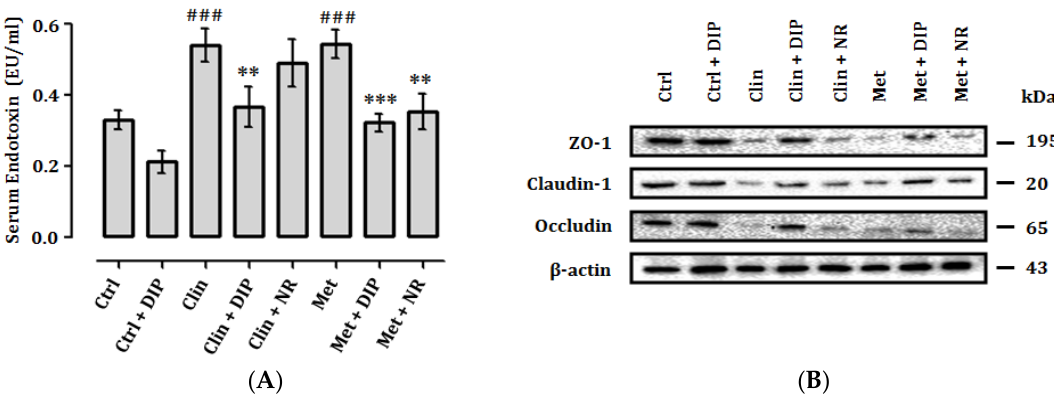
Figure 8. DIP treatment reduced serum endotoxin (lipopolysaccharide, LPS) levels and increased intestinal tight junctions in antibiotic-treated mice. ( A ) Effect of DIP on antibiotic-induced endotoxemia. Serum endotoxin (EU mL − 1 ) was measured using a Limulus amoebocyte lysate assay kit. LPS levels were higher in antibiotic-treated groups (Clin/Met) as compared to the Ctrl group. The data are presented as the means ± standard error of mean (SEM) ( n = 6). Statistical significance was assessed by one-way analysis of variance (ANOVA) followed by Tukey’s multiple comparison test and is represented as follows: ### p < 0.001 compared to control, ** p < 0.01, *** p < 0.001 compared to the respective antibiotic group (Clin/Met)). ( B ) Effect of DIP on tight-junction protein expression in the colon. Expression of claudin, occludin, and zonula occludens-1 (ZO-1) in different treatment groups using β -actin as an internal control. Western blots are representative of three independent experiments.